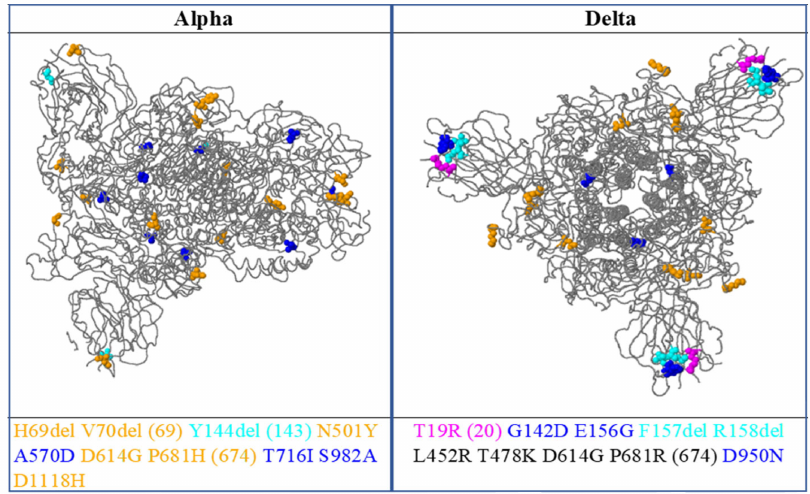
Figure 5. D structural visualization of the spike glycoprotein with amino acid changes, as shown as colored